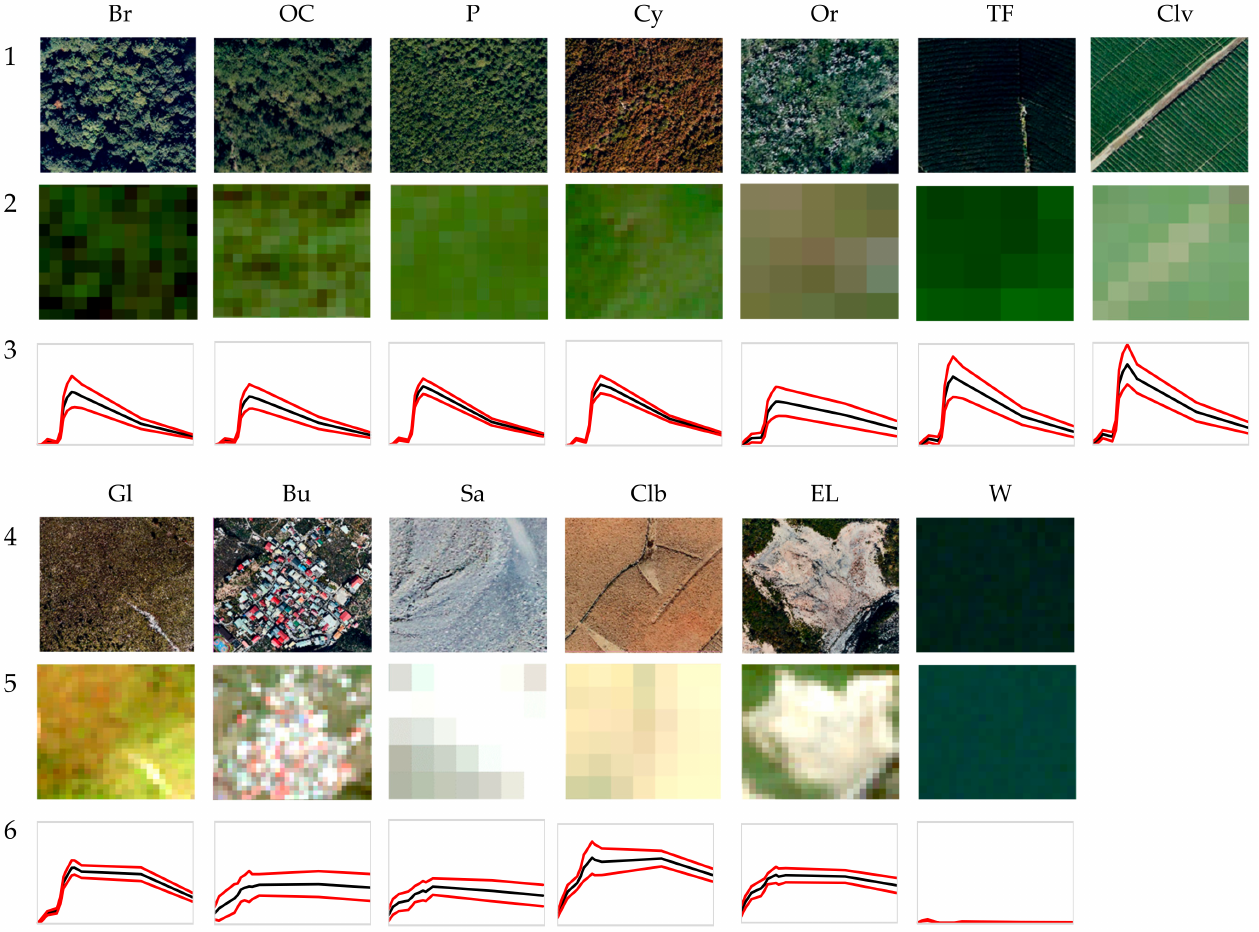
Figure 5. Variations of spectral feature for Level-III LULC classes. Images list in rows 1, 2, 3 and rows 4, 5, 6 represent high-resolution orthophoto image (1 and 4), Sentinel-2 image (2 and 5), and VNIR-SWIR spectral curve (3 and 6) (the cirrus band is excluded), respectively, of the specific class that came above them. Every spectral curve in rows 3 and 6 whose x-axis is with a range identical to the integrated line graph while the range of y-axis is extended to 0.52 to show the data variation. The black and red lines depict the reflectance curves in the form of µ ± SD, where µ and SD stand for the mean and standard deviation of reflectance, respectively. Please refer to Table 1 for the abbreviations of Level-III LULC